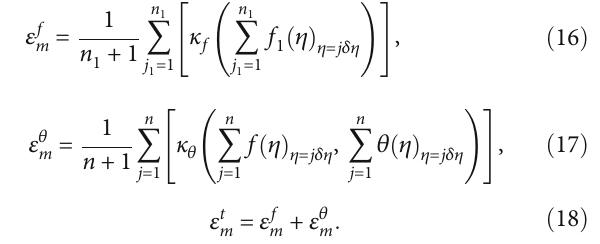
Table 3: Convergence control parameter for particular method.